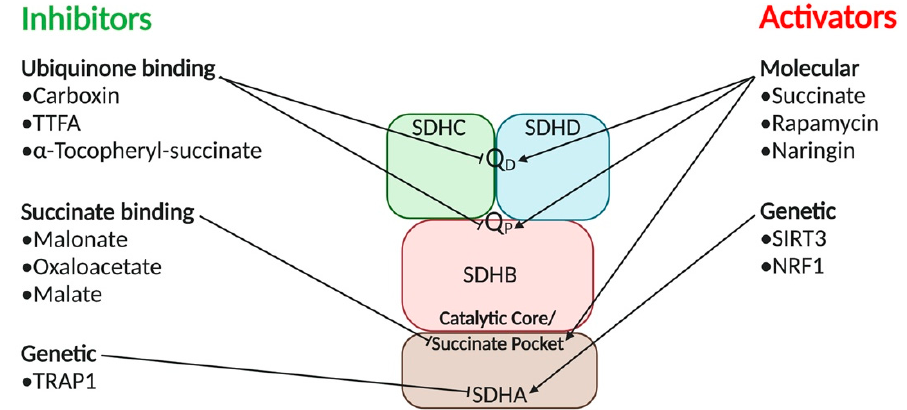
Figure 4. Strategies for Targeting Succinate Dehydrogenase Complex. Ubiquinone binding inhibitors carboxin, TTFA, and α -Tocopheryl succinate bind and deactivate SDH at the proximal Q P and